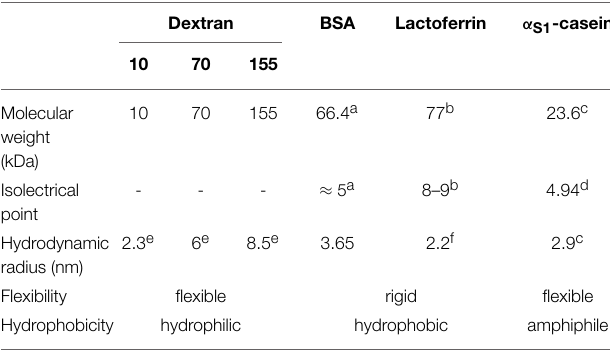
TABLE 1 | Physicochemical properties of the fluorescently-labeled